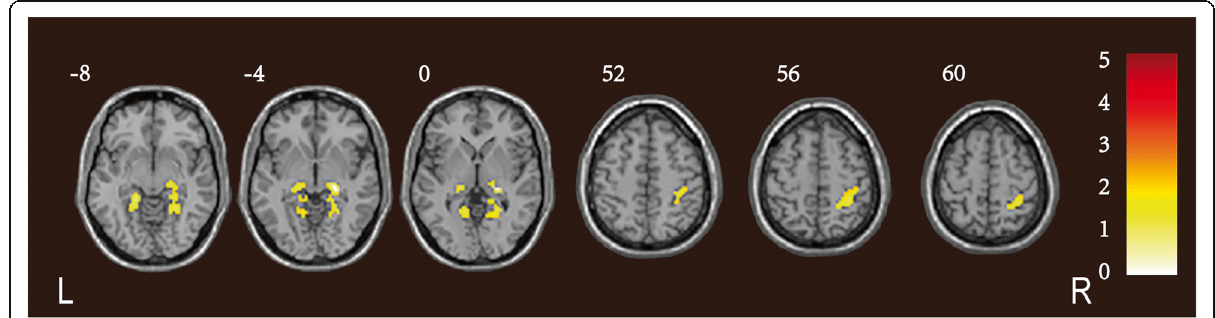
Fig. 3 Reductions in the FC between the right Pcu/CU and other brain areas in patients with CADASIL. The CADASIL group exhibited weaker FC between the right Pcu/CU and both PHGs, and between the right Pcu/CU and right postcentral gyrus, compared to controls. The t- values are color-coded. FC: functional connectivity; Pcu/CU: precuneus and cuneus; CADASIL: cerebral autosomal dominant arteriopathy with subcortical infarcts and leukoencephalopathy; PHG: parahippocampal gyrus